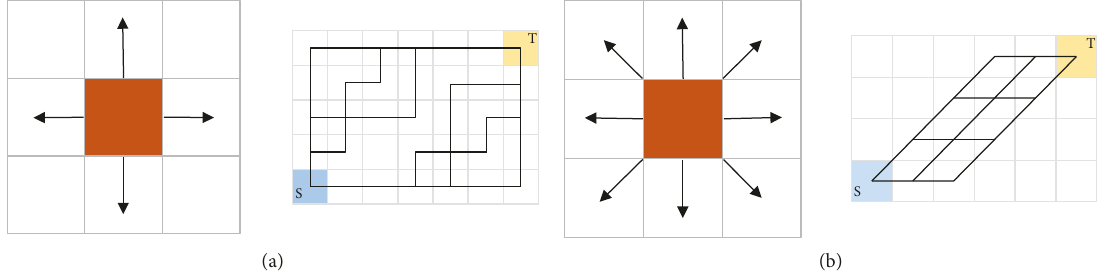
Figure 2: Symmetric path search. (a) Four-neighborhood search and symmetric path. (b) Eight-neighborhood search and symmetric path.